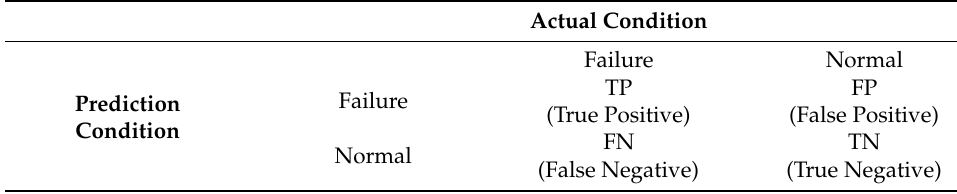
Table 2. Confusion matrix for fault diagnosis